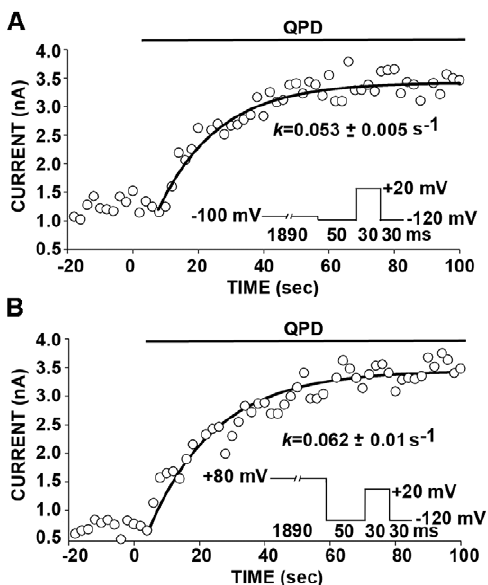
Figure 3. Kinetics of reformation of disulfide bond between W22C and W203C in the closed state (A) and in the open state (B). Outside-out patches were bathed in 10 mM DTT (pH 7.5) for 5 min. During the subsequent application of 40 m M QPD, membrane potential was held for 1890 ms at either 2 100 mV (A) or + 80 mV (B). After 50 ms at 2 120 mV, the patch was depolarized to + 20 mV for 30 ms and hyperpolarized to 2 120 mV for 30 ms, during which the tail current was recorded. This cycle, represented in the insets, was repeated every 2 s. The peak amplitudes of the tail currents are plotted against elapsed time. The data were fit with a single exponential function. The means of the rate constants from the least-squares fits of 5 independent experiments are given under the curves. The pipette solution contained 10 m M Ca 2 + . N= 4 for closed state and n=5 for open state. P= not significant by unpaired Student’s